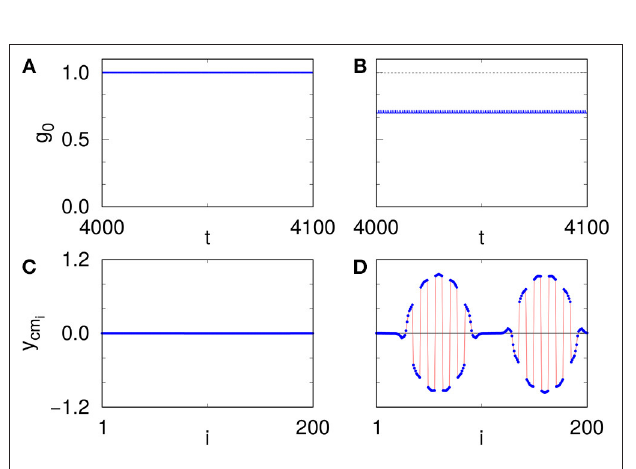
FIGURE 5 | With local low-pass filtering: (A,B) The time evolution of g 0 corresponding to the synchronized (A) and AC (B) state as marked in Figure 4A by ( (cid:4) ) ( α 25) and ( H ) ( α 35), respectively. (C,D) The = = corresponding center of mass ( y cm i ) for the above two points, showing synchronized (C) and AC (D) states, respectively. Other parameters are P 10, ε 25 and ω 2. = = =